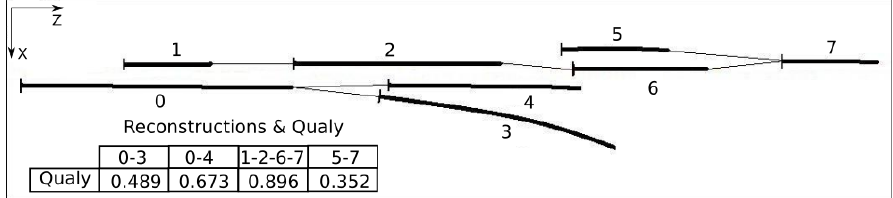
Figure 14. Example of lane marking reconstructions resulting from fragments connection.